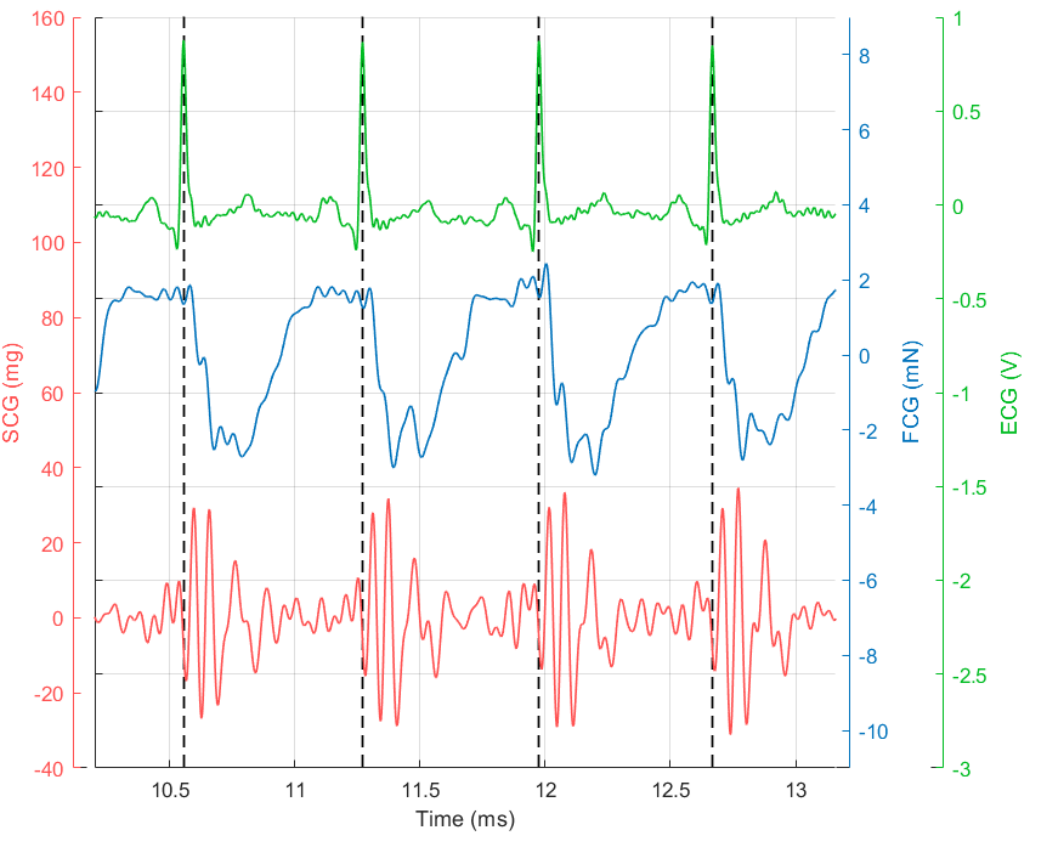
Figure 3. Subject #2 dataset: electrocardiograph (ECG) is shown in green and scaled in mV, FCG is shown in blue and scaled in mN and seismocardiography (SCG) (dorso-ventral acceleration) is shown in red and scaled in mg. The R-peaks time references correspond to the black dashed lines.